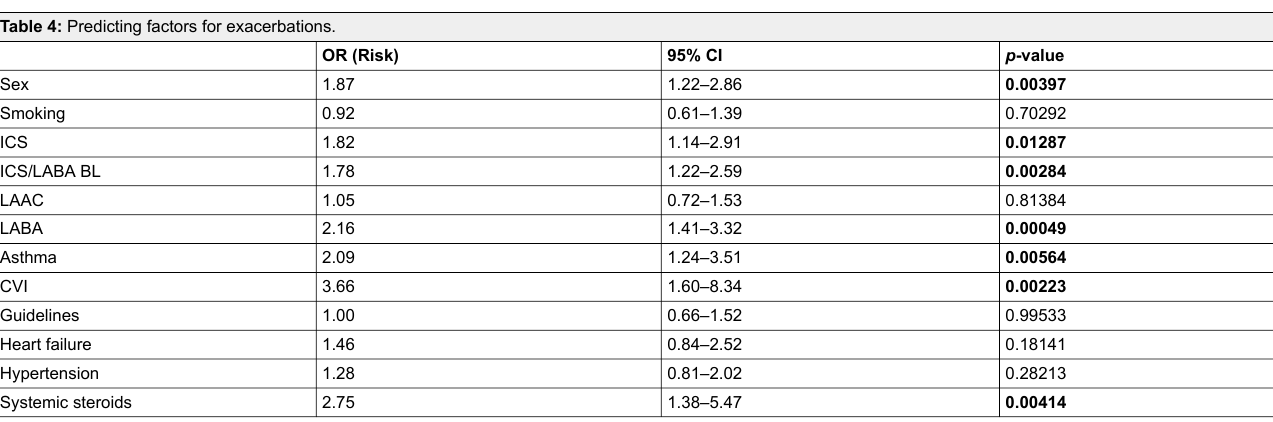
Table 4: Predicting factors for